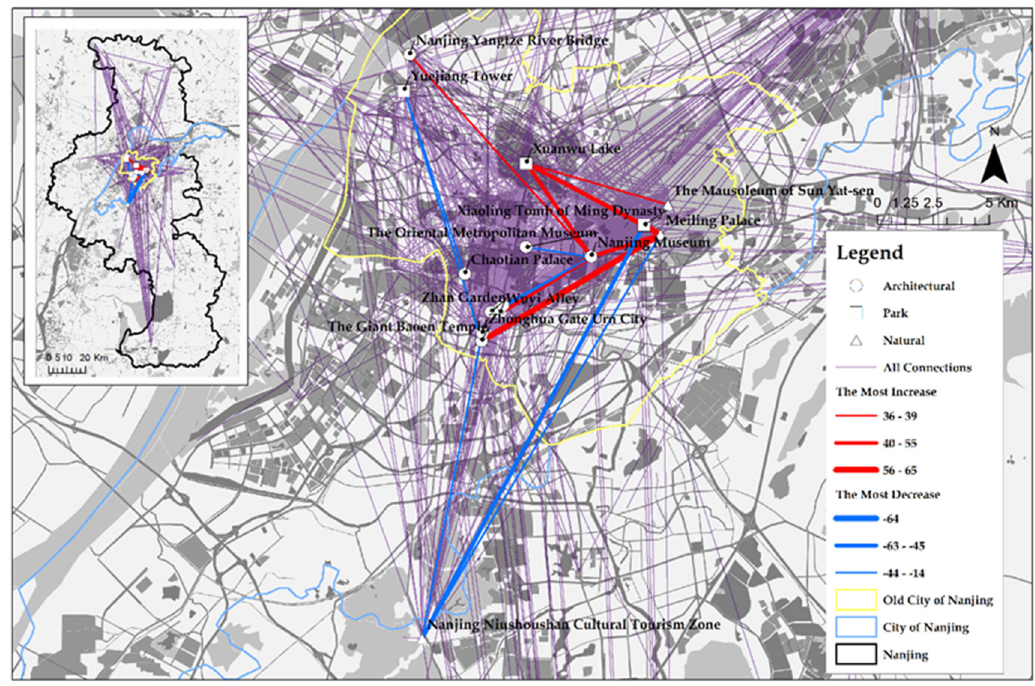
Figure 6. The exiting tourist routes with changes in Nanjing.